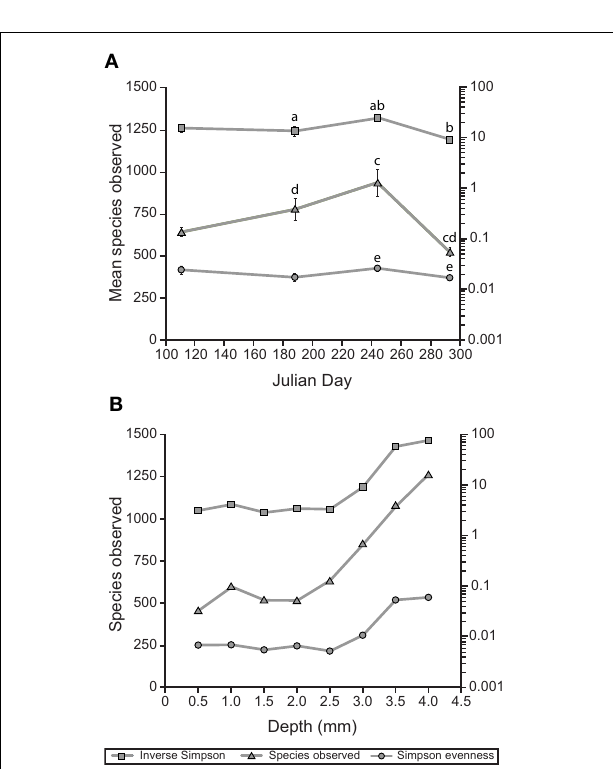
FIGURE 8 | Alpha diversity of the Hot Lake mat community. (A) Alpha diversity, richness, and evenness around the seasonal cycle. Unitless Simpson values are plotted on the left axis. Error bars represent standard error of the mean. Statistically significant differences ( p < 0 . 05) are labeled above the point with the same letter. (B) Depth gradient in alpha diversity, richness, and evenness. Unitless Simpson values are plotted on the left axis. Depths are reported as the maximum for each sample (i.e., 0.5mm denotes